Question: Write a single sentence explaining what this figure depicts.
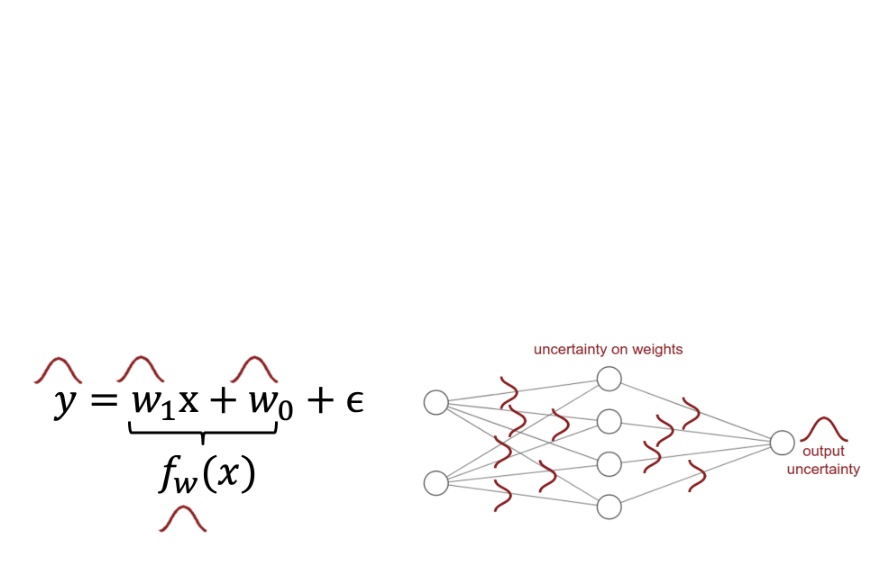
Answer: We need many models to quantify the epistemic uncertainty. This can be done explicitly by having multiple models as in ensembles or implicitly by introducing probability distributions over the parameters (weights of the neural network) of the ML model.